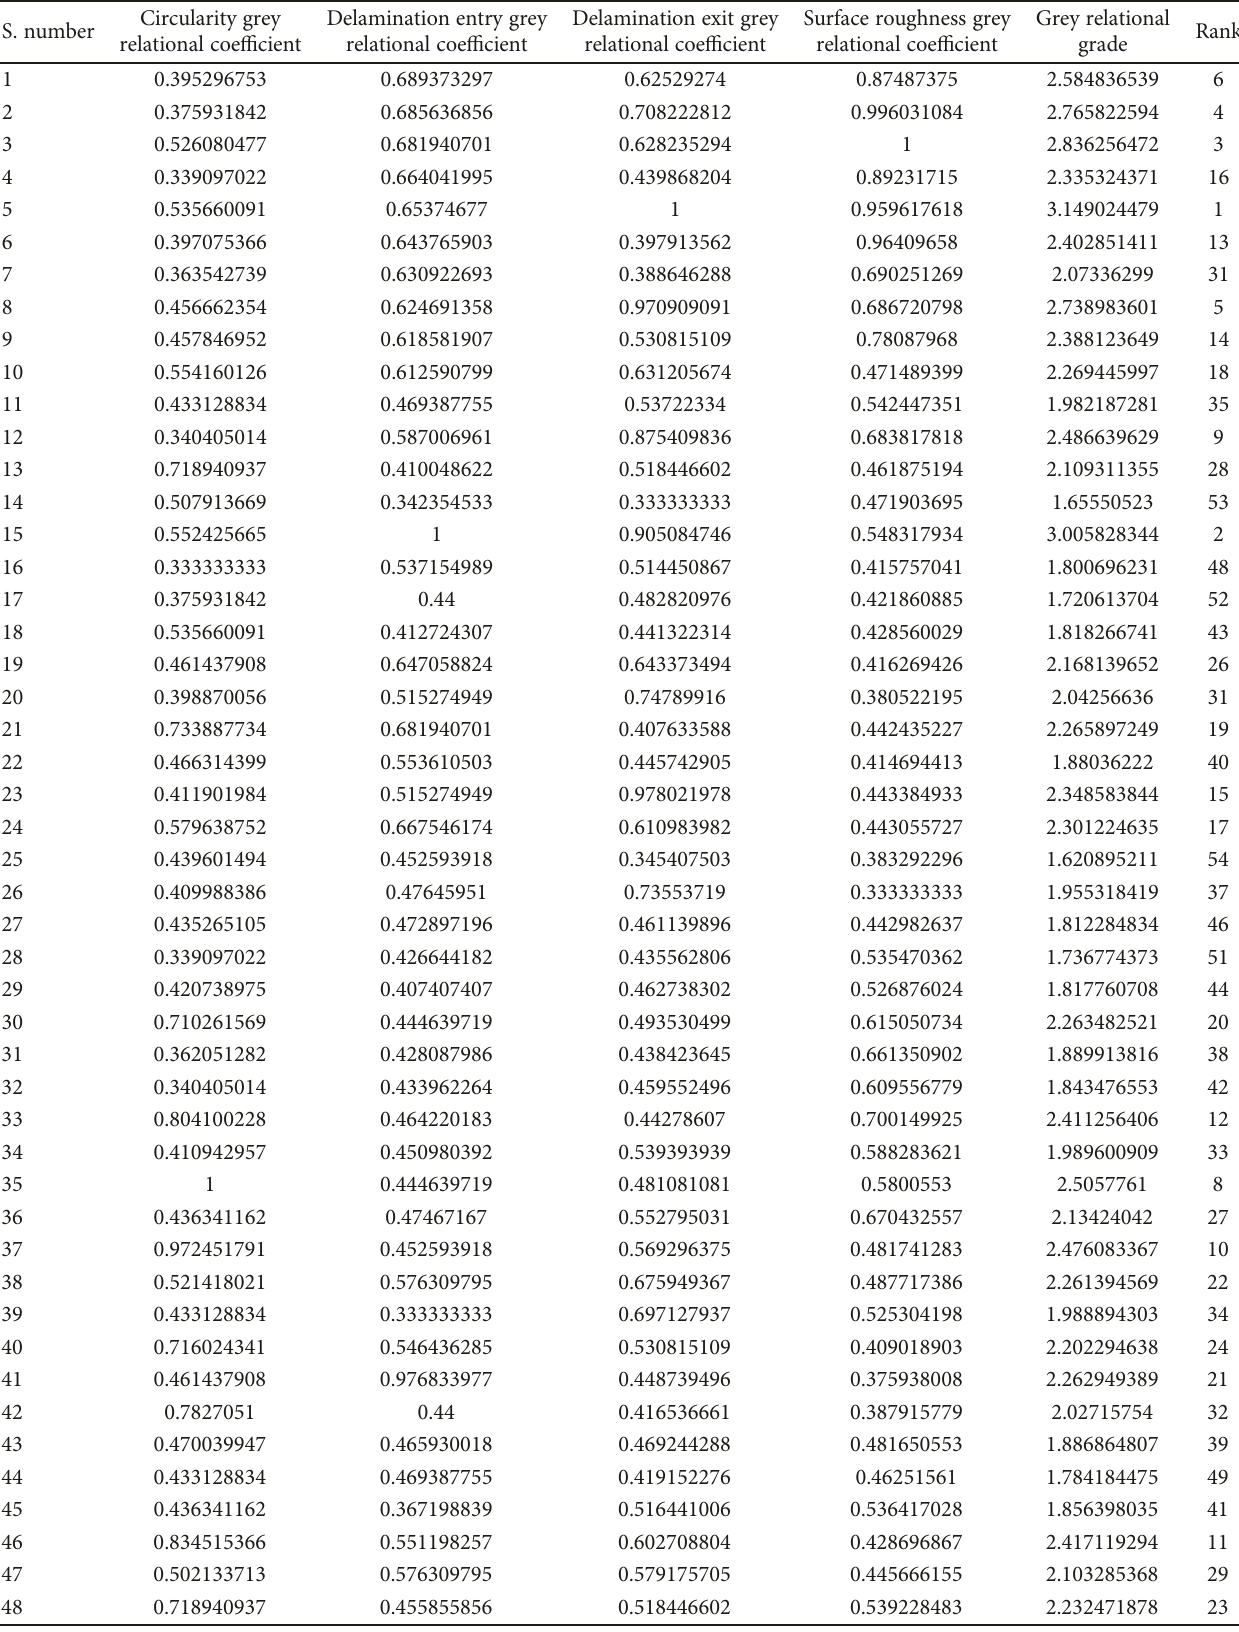
Table 7: Grey relational